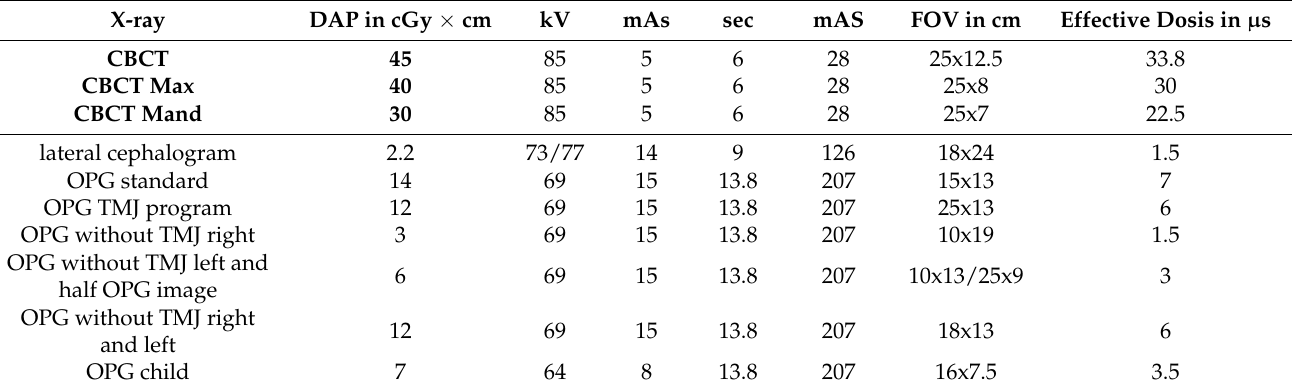
Table 2. Dose area product per X-ray examination (DAP: dose area product, FOV: field of view/field size, OPG: orthopantomogram, TMJ: temporomandibular joint, CBCT: cone beam computed tomog- raphy) and effective dose per X-ray